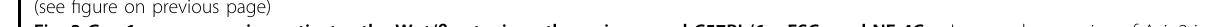
Fig. 3 Gcm1 overexpression activates the Wnt/ β -catenin pathway in normal C57BL/6 mESCs and NE-4C. a Increased expression of Axin2 in mESCs with Gcm1 overexpression. The western blots show that the Gcm1 overexpression plasmid increased Axin2 expression in normal C57BL/6 mESCs. PGMLV-Gcm1, Gcm1 plasmid. mESCs were transfected with either control siRNA or pGMLV-Gcm1, and the expression levels were determined 72 h post transfection by western blotting. b A Co-IP assay was used to identify the interaction between Gcm1 and β -catenin in cells transfected with pGMLV-Gcm1 overexpression plasmid in C57BL/6 mESCs. An anti-Gcm1 antibody was used for IP, and IB was performed using an anti- β -catenin antibody. c A Co-IP assay was used to identify the interaction between Gcm1 and TCF4 in cells transfected with pGMLV-Gcm1 overexpression plasmid in C57BL/6 mESCs. An anti-Gcm1 antibody was used for IP, and IB was performed using an anti-TCF4 antibody. d A Co-IP assay identi fi ed increase interactions between TCF4 and β -catenin in cells transfected with 0.5, 2, and 4 µg of pGMLV-Gcm1 for 72 h in C57BL/6 mESCs. e A Co-IP assay was used to identify the interaction between Gcm1 and TCF4, β -catenin in NE-4C cells transfected with the pGMLV-Gcm1 overexpression plasmid. An anti-Gcm1 antibody was used for IP, and IB was performed using an anti-TCF4 antibody and anti- β -catenin antibody. f The mRNA expression of Fzd5, Lrp, Wnt6, Ccnd1, Nfat5, Lef1, Tcf4, Tcf12, Bcl9L , and Axin2 in C57BL/6 mESCs transfected with the overexpression vector pGMLV- Gcm1. The mRNA was extracted from the mESCs after transfection with pGMLV-Gcm1 for 72 h. g Analysis of luciferase activity by TOP/FOP Flash assays in C57BL/6 mESCs transfected with pGMLV-Gcm1 overexpression plasmid relative to those transfected with scramble plasmid in normal and LiCl medium. LiCl (10 mmol) was added to the control medium before 72 h of transfection. Data a – g represent the mean ± SEM ( n = 3). The p value was calculated by Student ’ s t -test, ns was for no signi fi cance, * P < 0.05, ** P < 0.01, *** P <